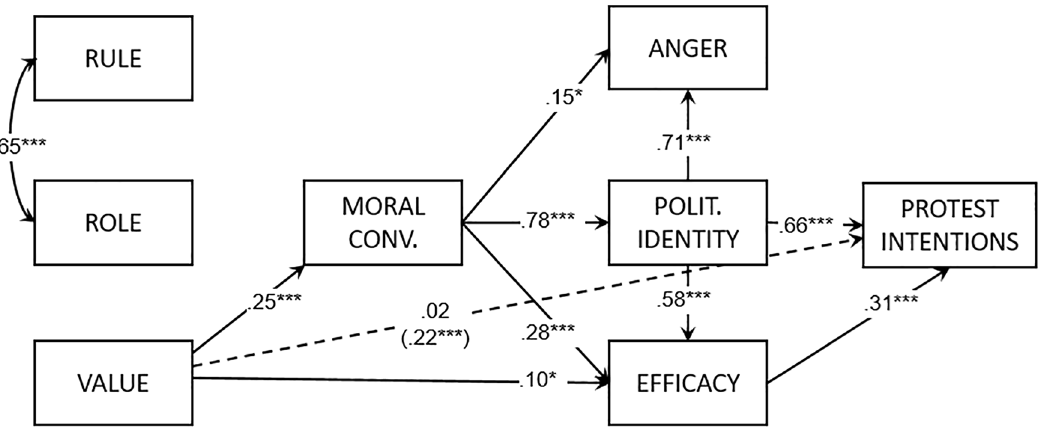
Figure 5. Path model of Study 3 (human rights-protecting protest group). Note . Reported coefficients are standardized. Between parentheses, the indirect effect from the orientation to protest intentions. Polit. =